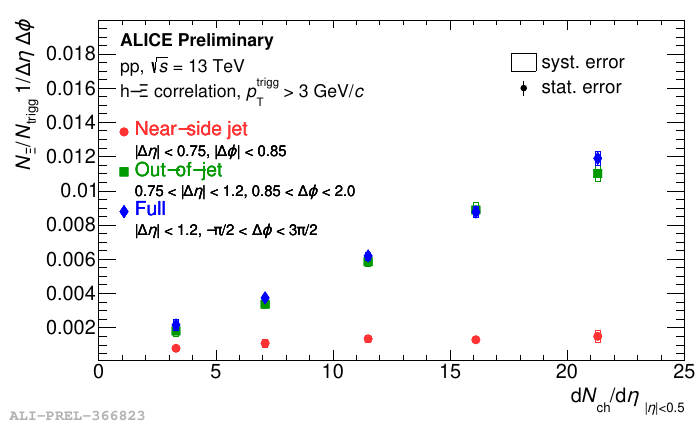
Figure 1: Ξ yields per trigger particle and per unit of ∆ η ∆ φ as a function of the charged-particle multiplicity produced at midrapidity.